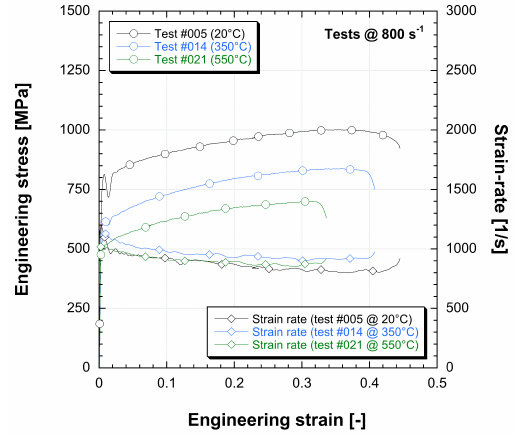
Figure 3: Engineering stress and strain-rate versus time. Representative data for as-cast tests performed at 800 s − 1